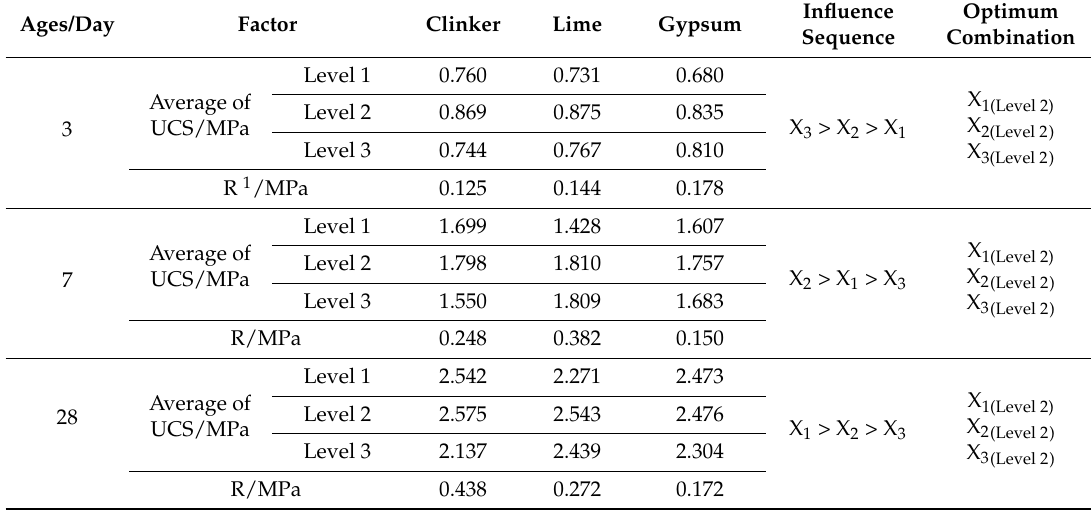
Table 4. Range analysis results for the UCS